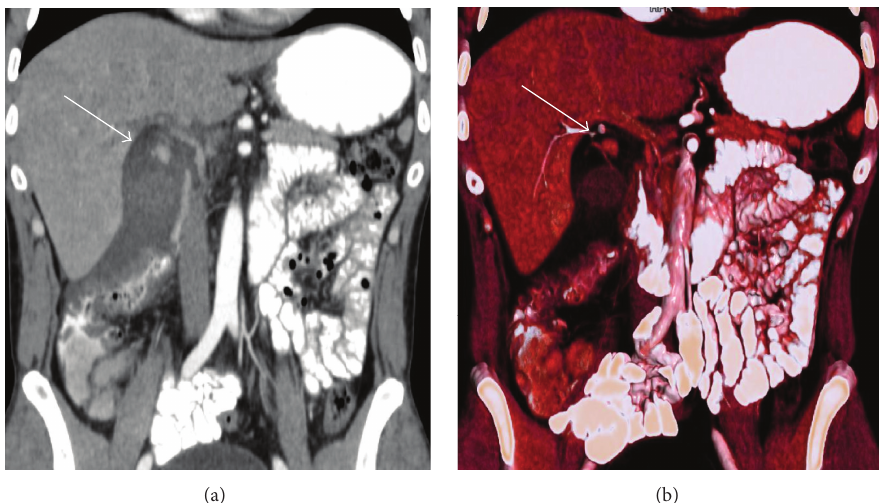
Figure 1: Coronal (a) and 3D reformatted images (b) of the patient. Arrows are indicating small cystic artery pseudoaneurysm.